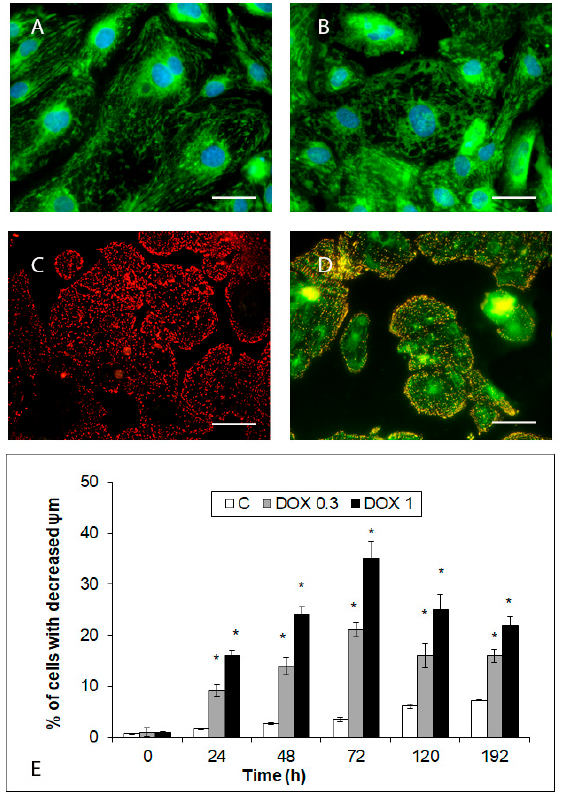
Figure 6. Effects of 1 and 0.3 µM DOX on mitochondrial topography and activity in hiPCS-CMs during 192 h. Mitochondrial morphology and arrangement in ( A ) control and ( B ) 1 µM DOX-treated cells (72 h) was examined by microscopic evaluation of MitoTracker Green FM fluorescence. Mitochondrial membrane potential ( ψ ) in ( C ) control and ( D ) 1 µM DOX-treated cells (72 h) was examined by microscopic measurement of potential-sensitive JC-1 dye. Software-aided cell quantitation of ψ in 0.3 and 1 µM DOX-treated cells during 192 h ( E ) as described in Materials and methods section. Fluorescence 400× ( A , B ) and 200× ( C , D ). Bars 10 µm ( A , B ), 30 µm ( C , D ). * p < 0.05 compared to untreated control cells at the same treatment interval with one way-Anova test and Dunnett’s post test for multiple comparisons.